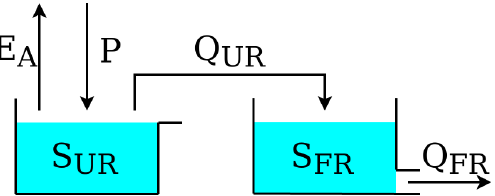
Figure 3. Schematic of model M4 used in the original SUPER- FLEX case studies of Kavetski and Fenicia